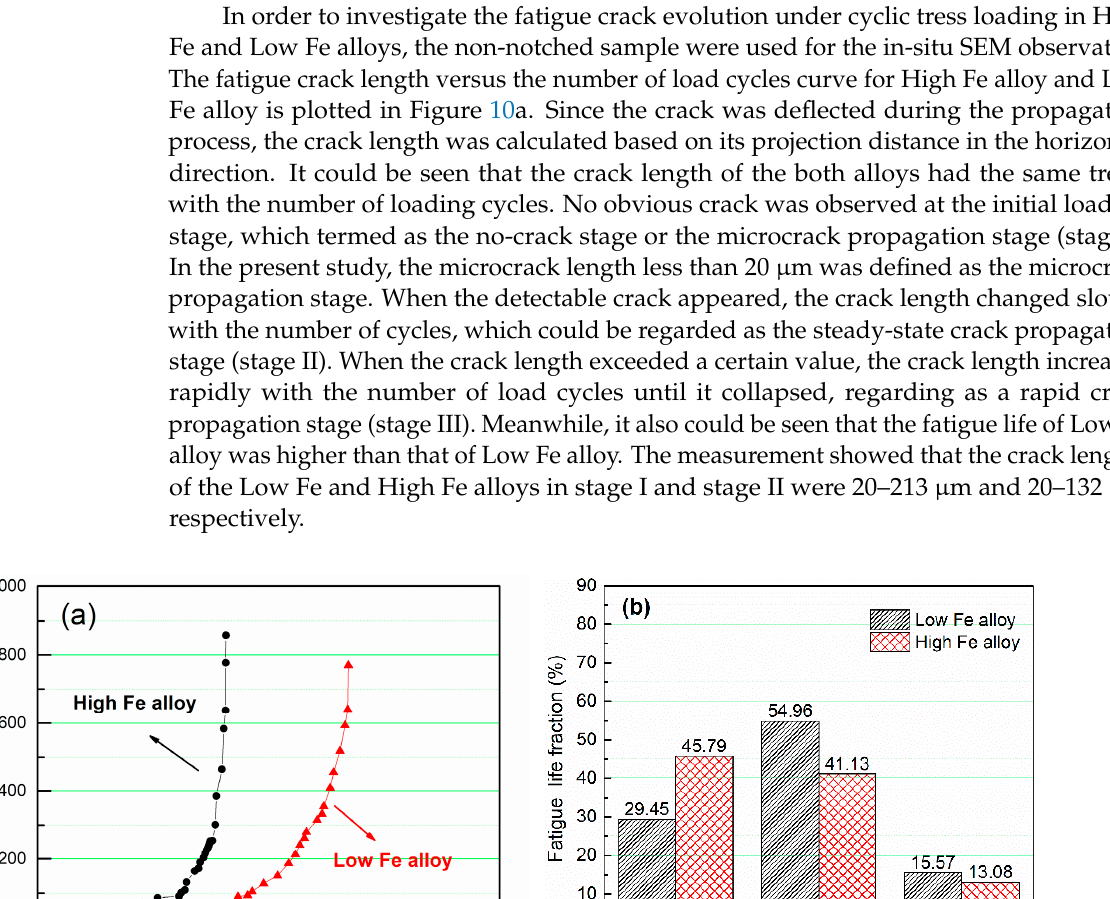
Figure 9. SEM fractography of Al-Cu-Li-Mg-Zr alloys in high growth rate regime. The micro- graphs collected at ( a , c ) a lower magnification and ( b , d ) a higher magnification for ( a , b ) High Fe